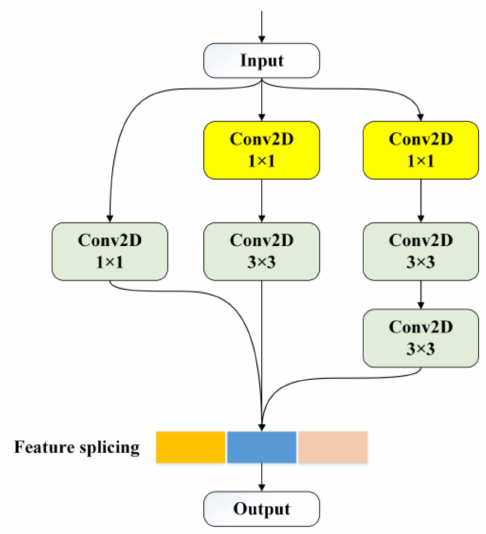
Figure 5. Multiscale branching structure.